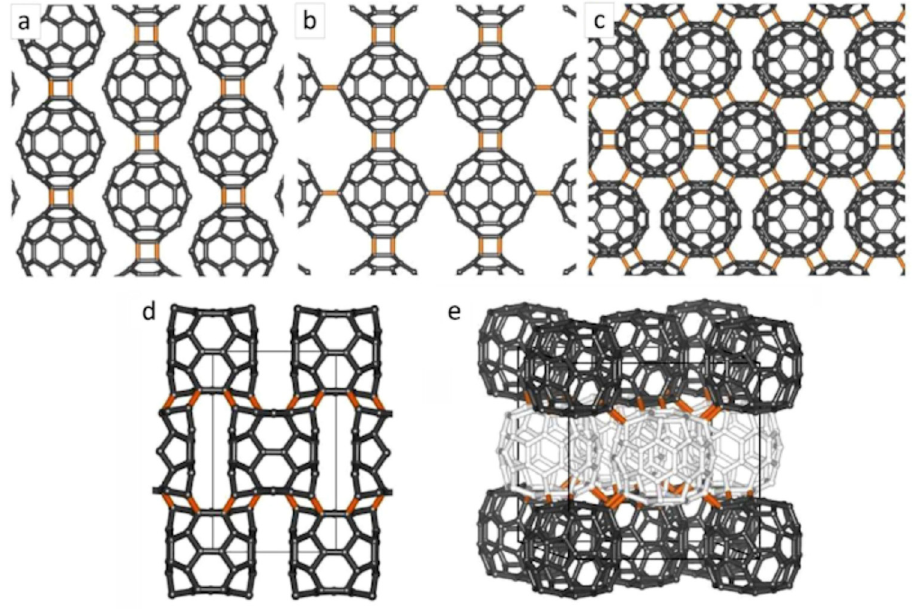
Figure 7. All carbon polymerised C 60 structures. ( a ) 1D, ( b ) 2D-tetragonal, ( c ) 2D-rhombohedral, ( d ) 3D cuboidal, ( e ) 3D AuCuI-type. Adapted from [67].